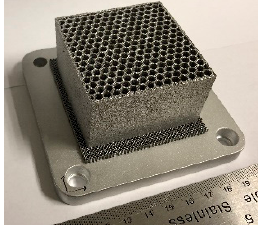
Figure 9. 3D collimator structures (honeycomb).